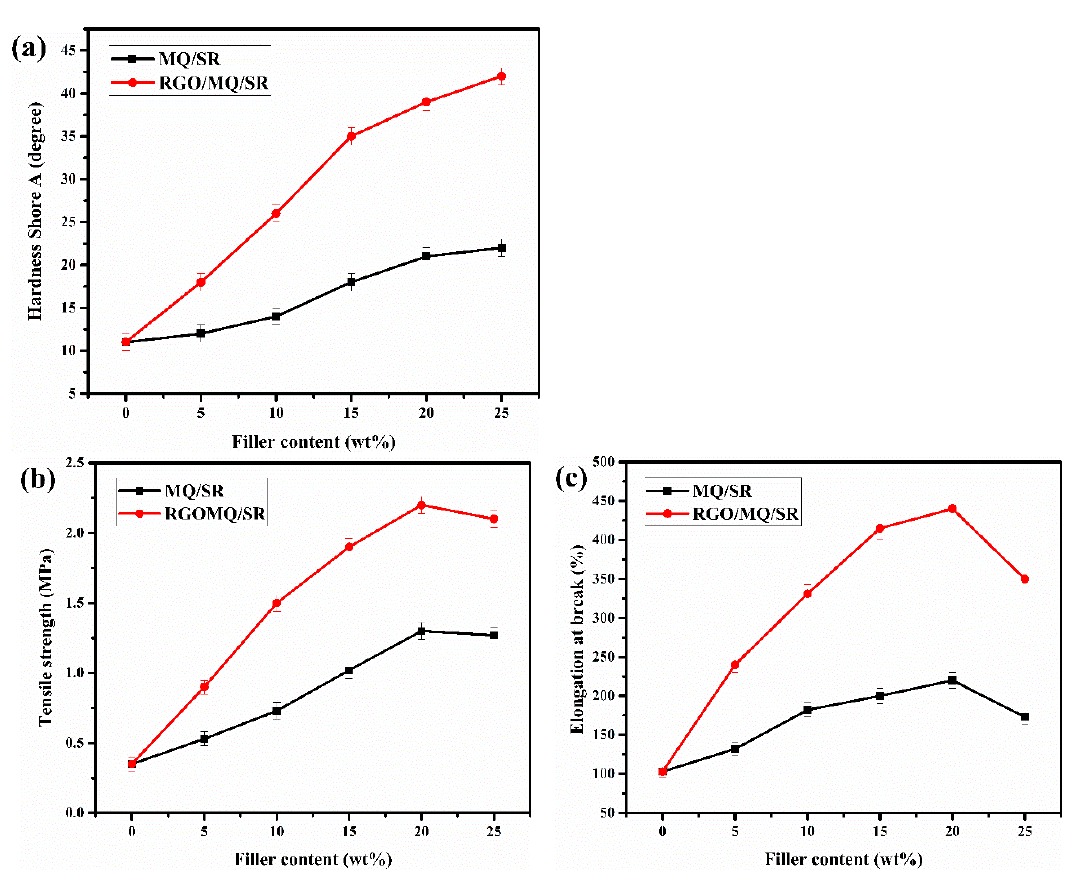
Figure 8. Effects of MQ and RGO/MQ content on ( a ) Shore A hardness, ( b ) tensile strength and ( c ) elongation at break of silicone rubber composites.